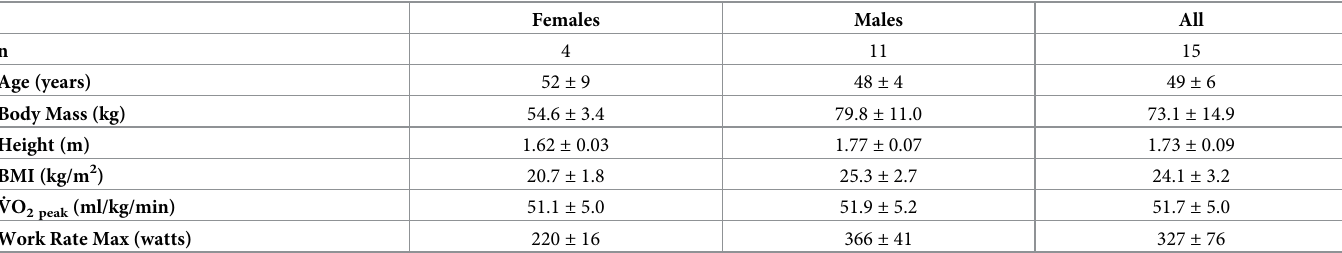
Table 1. Descriptive characteristics of subjects completing the